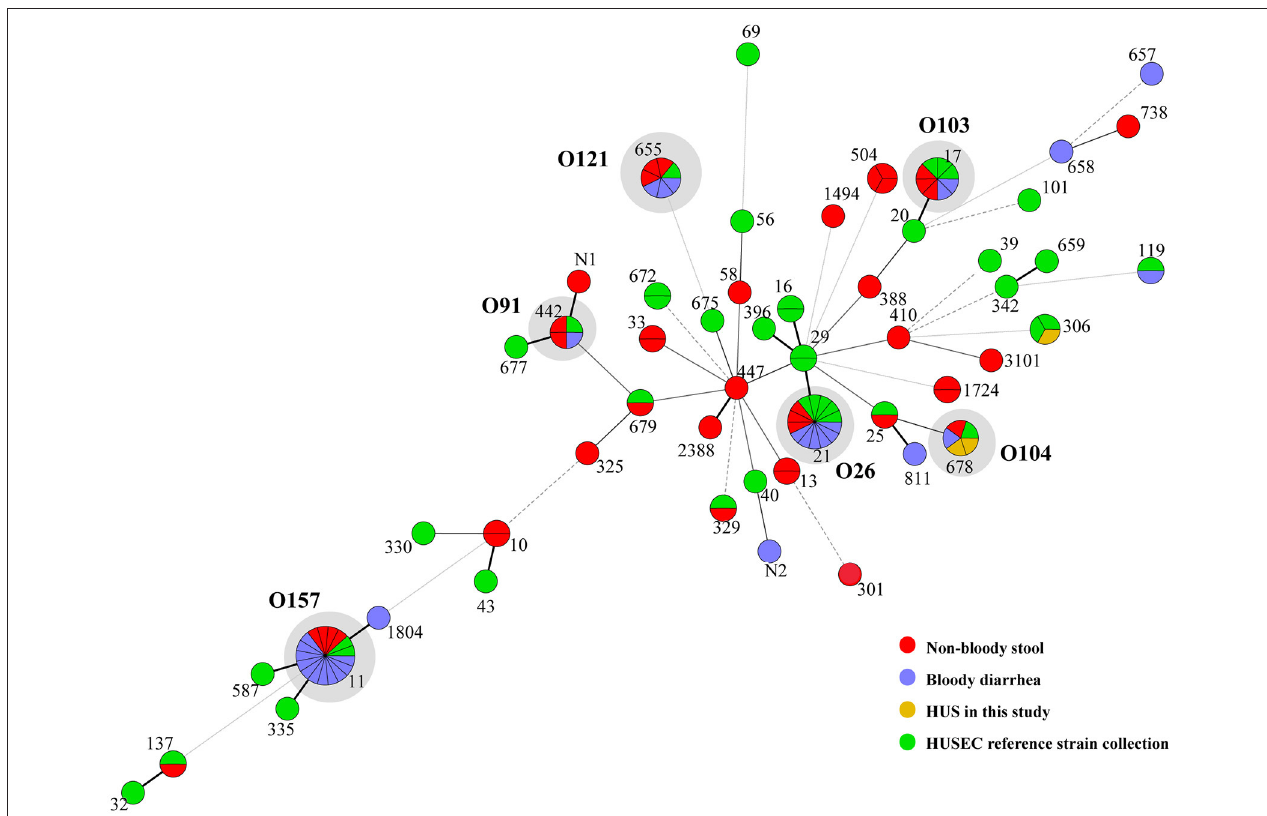
FIGURE 1 | Minimum spanning tree of 33 STs in this study and 31 STs from HUSEC collection. Each circle represents an ST with the size being proportional to the number of isolates. The colors for the slices of the pie represent the sources of isolates (see labeling in the lower right corner). The predominant STs comprising of strains in this study and HUSEC reference collection are indicated in gray shadows, with serogroups demonstrated